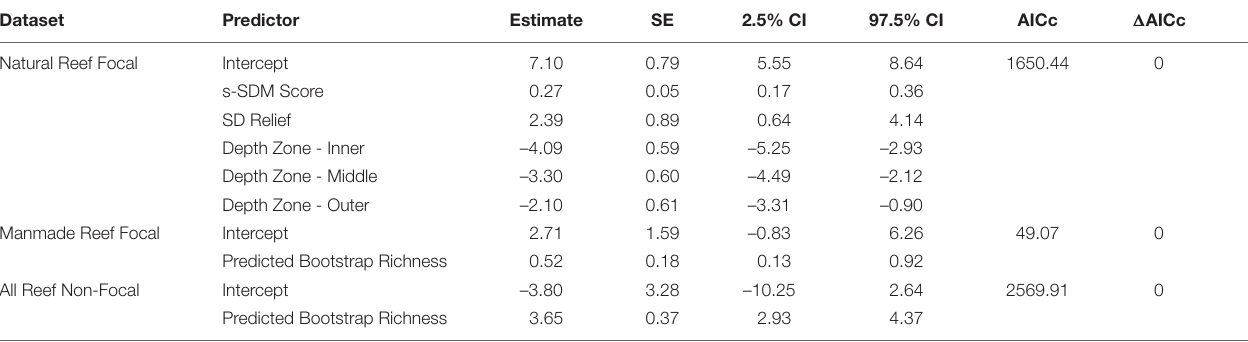
TABLE 2 | Linear regression results comparing s-SDM score with observed bootstrap species richness. Dataset